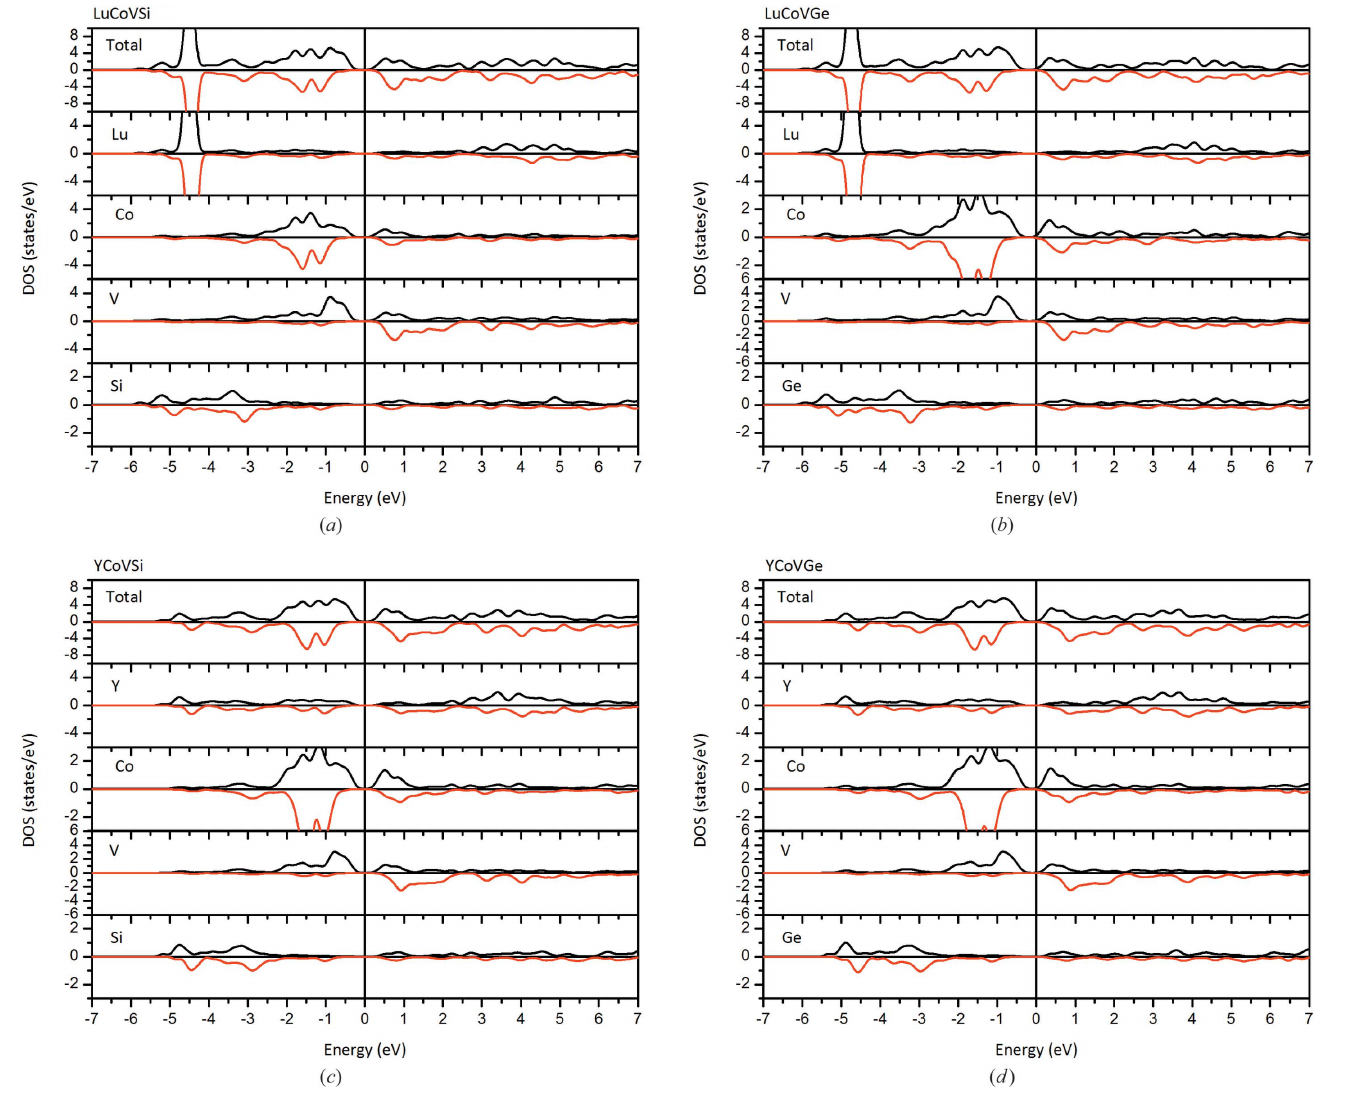
Figure 5 Calculated total and partial DOSs for ( a ) LuCoVSi, ( b ) LuCoVGe, ( c ) YCoVSi and ( d ) YCoVGe EQH